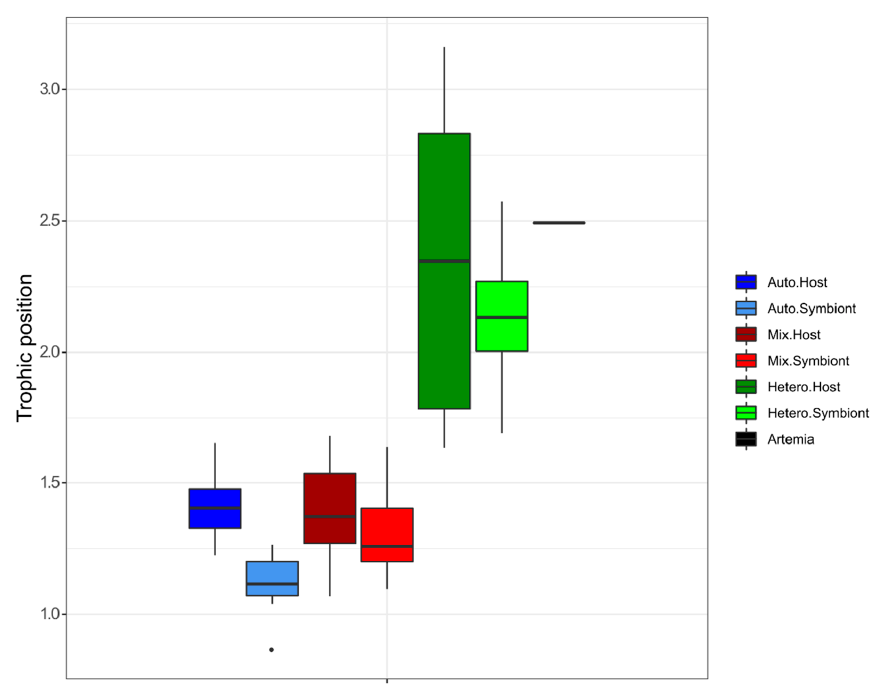
Figure 3. The value of the trophic position index according to the nutritional state of the coral holobiont: the autotrophic host and symbionts represented in blue, the mixotrophic host and symbionts in red and the heterotrophic host and symbionts in green.